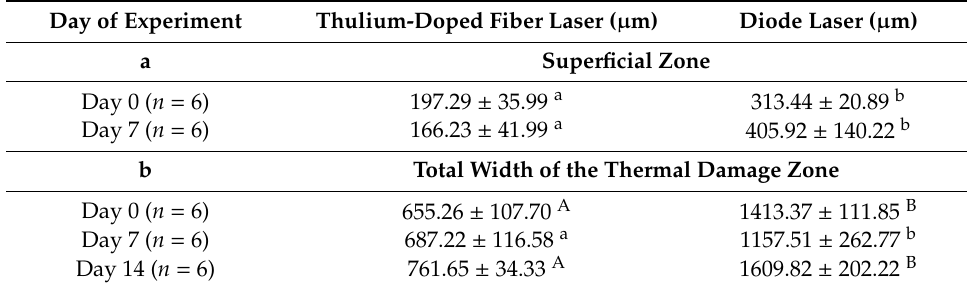
Figure 4. Histopathological sections of the spleen fragments collected intraoperatively at the site of cutting with the diode laser (DL). Black lines indicate the width of the entire zone of thermal damage (HE staining). ( A–C ) A quite wide superficial zone of the carbonized tissue and a deeper zone of thermal changes are visible (magnification × 40). Table 2. Dimensions of the thermal damage zones produced by cutting the spleen with a thulium-doped fiber laser (TDFL) and a diode laser (DL) on histopathological sections collected intraoperatively and on days 7 and 14 following